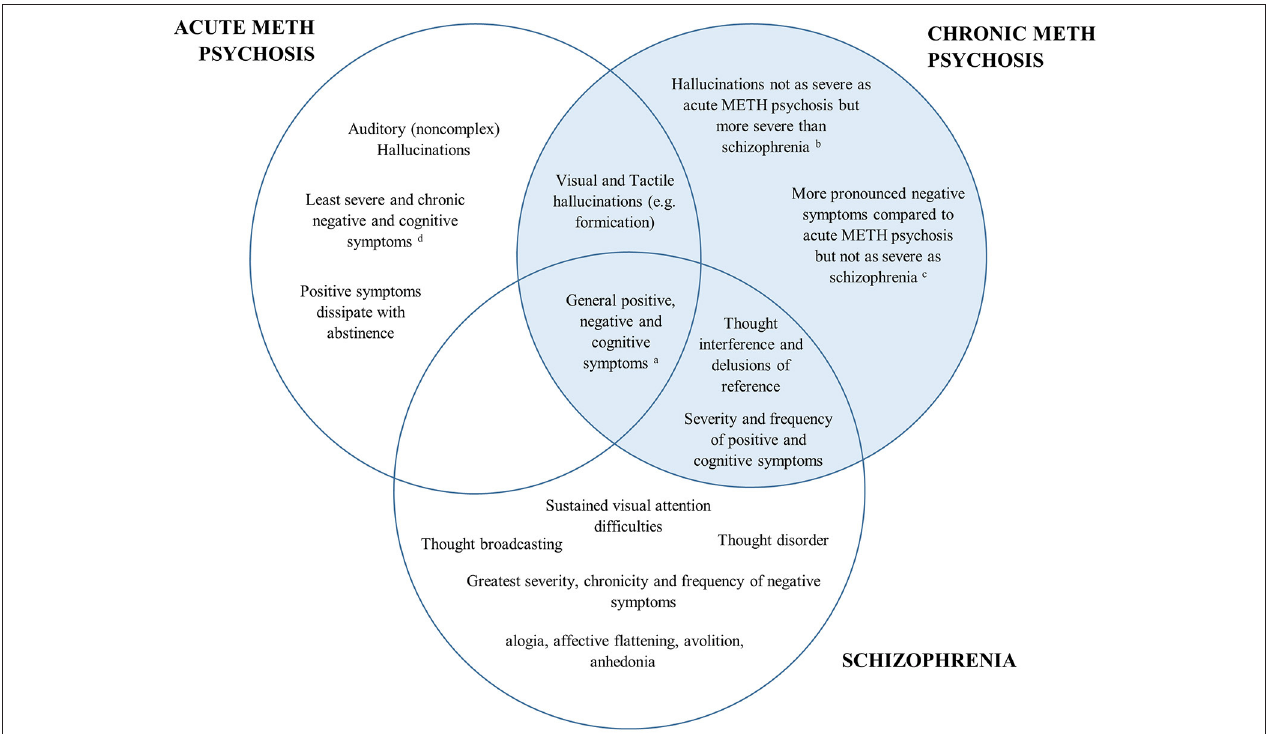
FIGURE 1 | Venn diagram of the overlap in psychiatric and cognitive symptomatology between acute METH psychosis, chronic METH psychosis, and schizophrenia. The left represents symptoms specific to acute METH psychosis, the right (highlighted blue) represents the symptoms and profile specific to chronic METH psychosis, while the bottom highlights those associated specifically with a schizophrenia profile. Symptoms that are common across disorders are shown in the overlap. a All conditions demonstrate some degree of positive, negative and cognitive symptomatology according the specific syndrome scales (e.g., Brief Psychiatric Rating Scale or the Positive and Negative Severity Scale). b Visual and tactile hallucinations: Acute METH psychosis > Chronic METH psychosis > Schizophrenia c Severity of negative symptoms: Schizophrenia > Chronic METH psychosis > Acute METH psychosis. d Cognition: Schizophrenia = Chronic METH psychosis > Acute METH